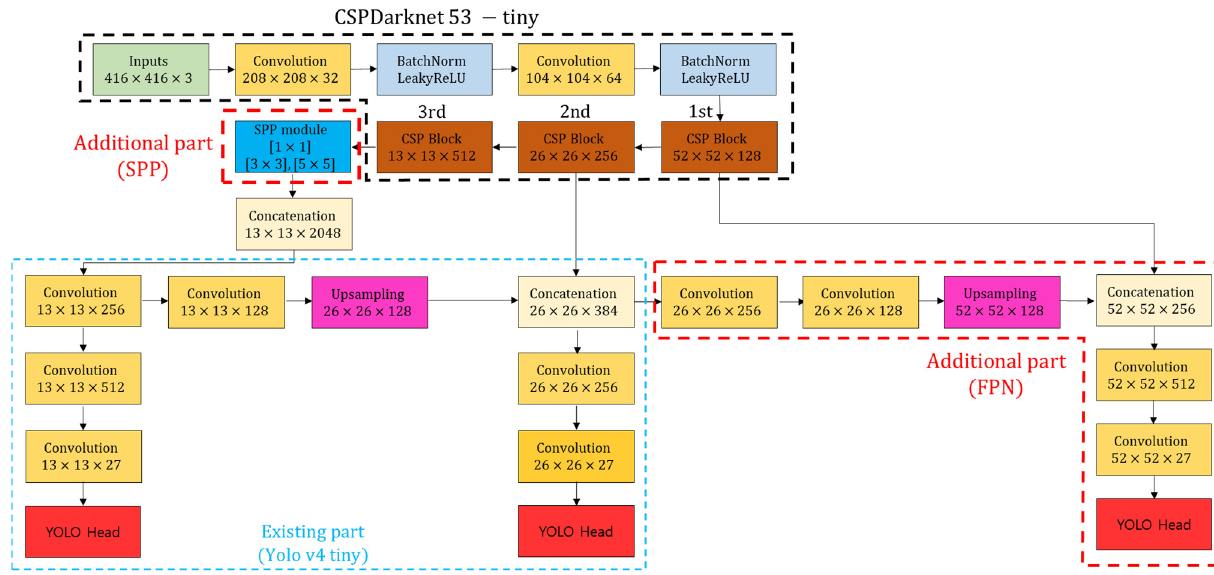
Figure 4. SPFPN YOLOv4 tiny overall